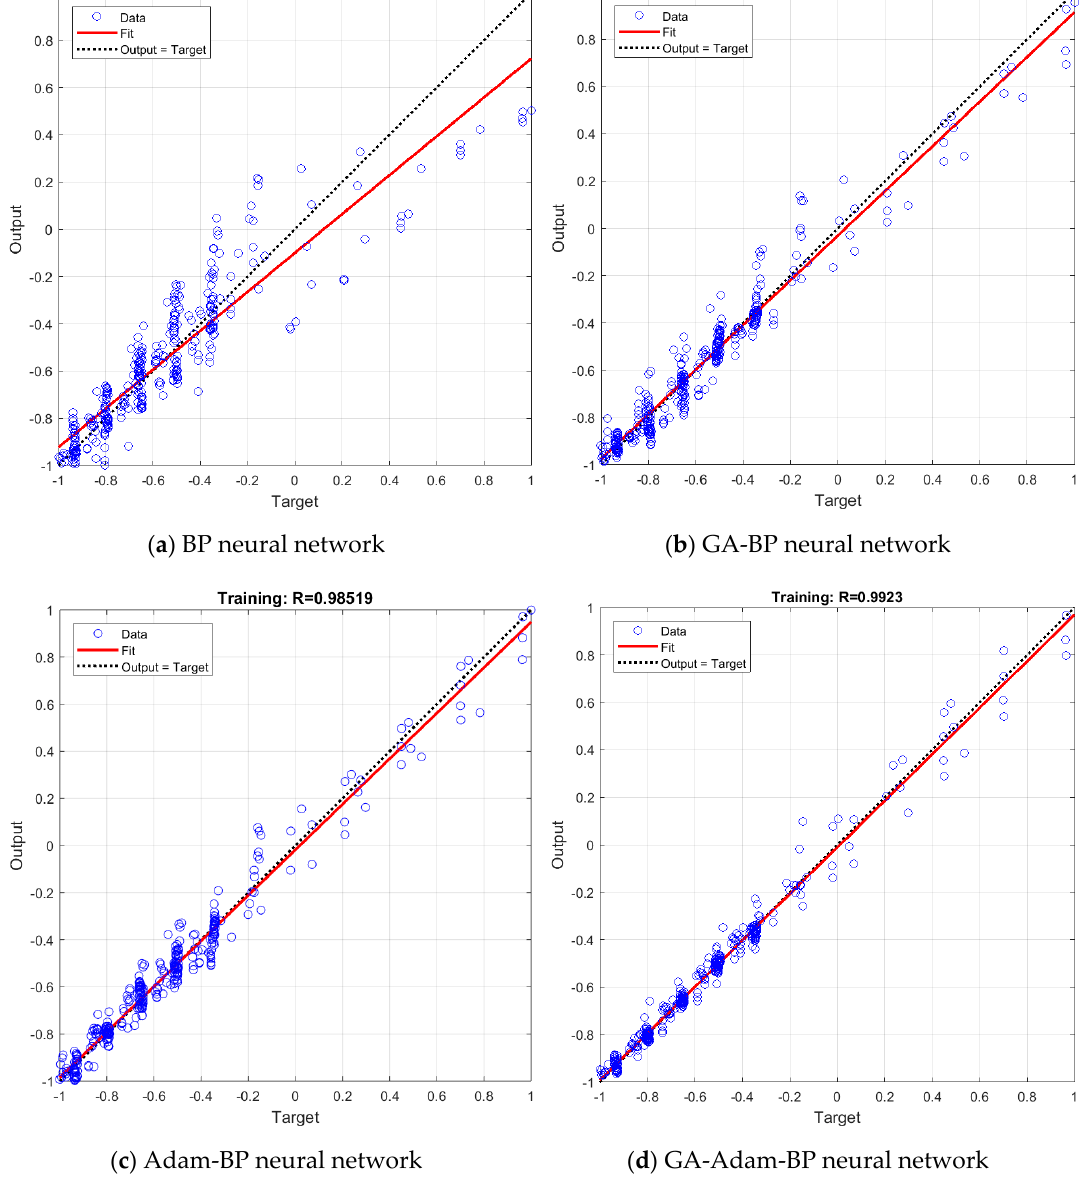
Figure 14. The regression analysis of four neural network models.